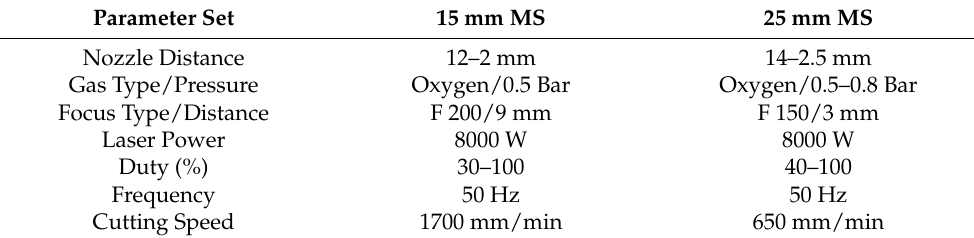
Table 5. Example piercing and cutting parameter set used in 8 kW tests.